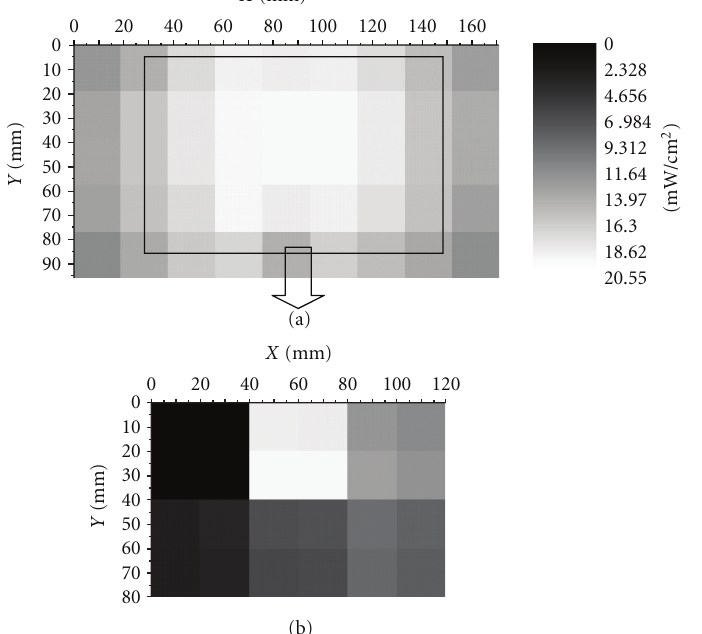
Figure 4: (a) Homogeneity of the irradiance for the irradiation distance of 164mm between the LED array and treatment area, and the rectangular area is approximately equal to the area of the standard multiwell plate used for PDT studies. (b) Under the six di ff erent attenuators, the irradiances of the rectangular areas were 0, 3.2, 7.0, 9.0, 12.7, and 20.3 mW/cm 2 , respectively.